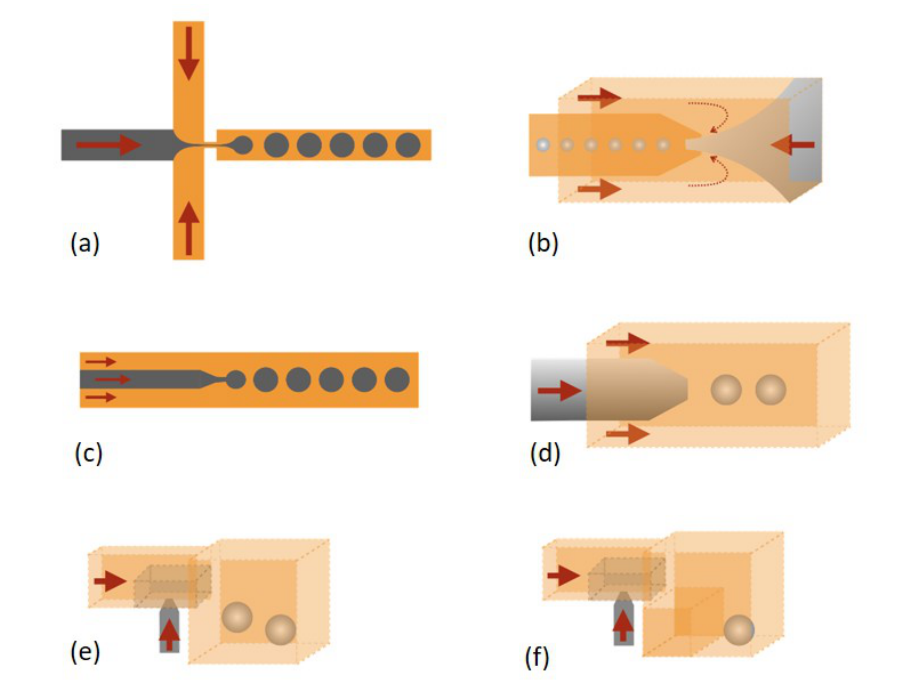
Figure 2. ( a ) Planar flow-focusing. ( b ) 3D axisymmetric flow-focusing. ( c ) Planar co-flow. ( d ) 3D axisymmetric co-flow. Step emulsification: ( e ) One step. ( f ) Two steps, or microchannel